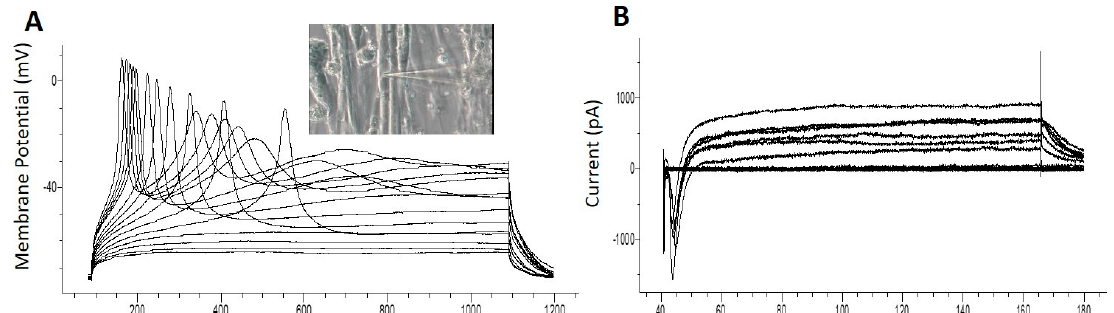
Figure5. ElectrophysiologicalanalysisbypatchclampinDay10cultures. After10daysofdi ff erentiation from myogenic progenitors, myotubes were sampled for patch clamp analysis. ( A ) Action potentials induced under current clamp conditions. The inset is an image of the recorded cell. ( B ) Sodium and Potassium currents recorded under voltage